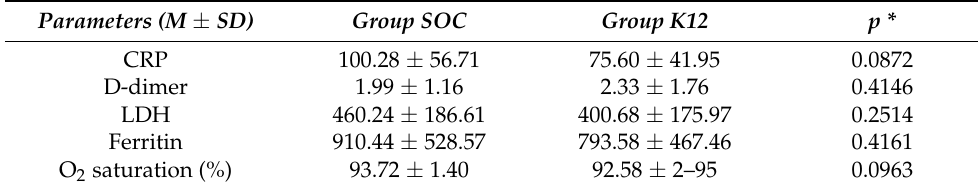
Table 3. Blood parameters and percentage of O 2 saturation in the enrolled